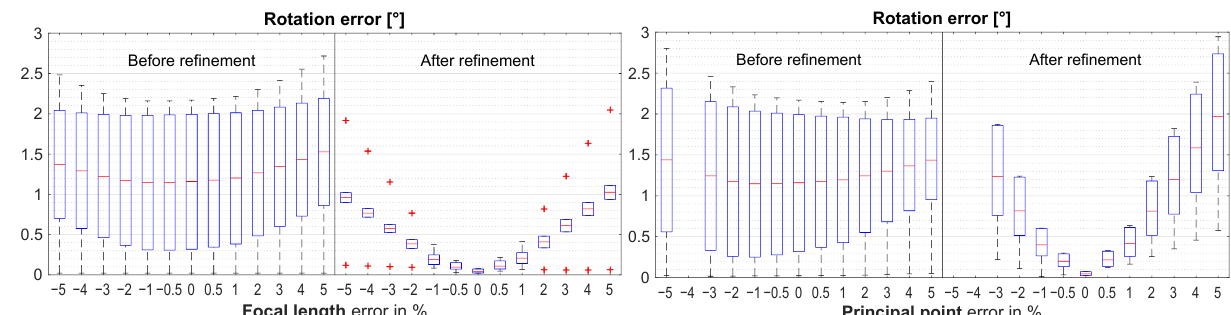
Figure 8. Results when introducing errors in camera intrinsics. Box plots are missing where the optimization did not converge.